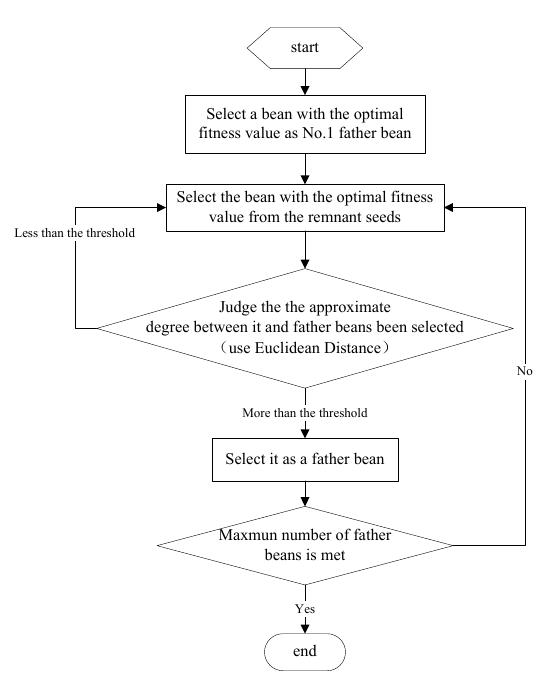
Fig.1 the Selection of Father Beans